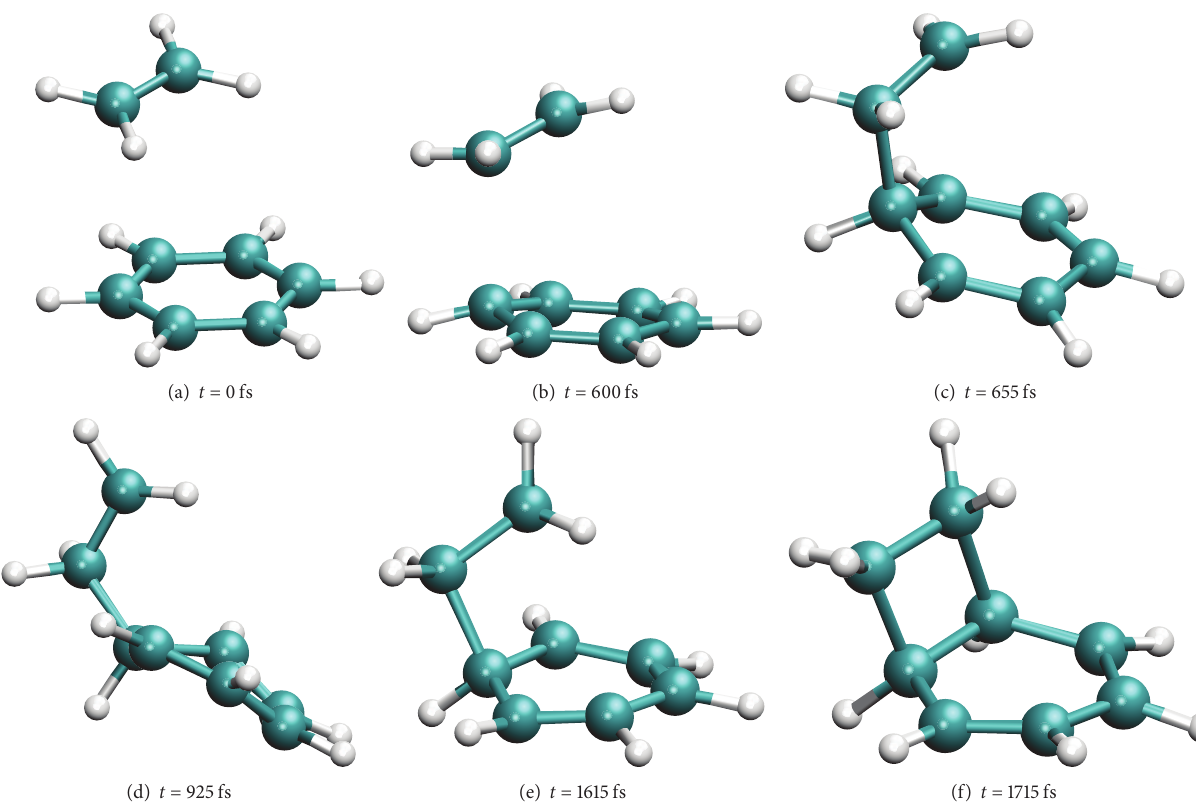
Figure 3: Snapshots taken from the simulation of asynchronous cycloaddition mode of stacked benzene and ethylene molecules at (a) 0, (b) 600, (c) 655, (d) 925, (e) 1615, and (f) 1715 fs. The benzene molecule is subjected to the irradiation of a 25 fs (fwhm) laser pulse with a fluence of 94.11 J ⋅ m −2 and photon energy of 4.7